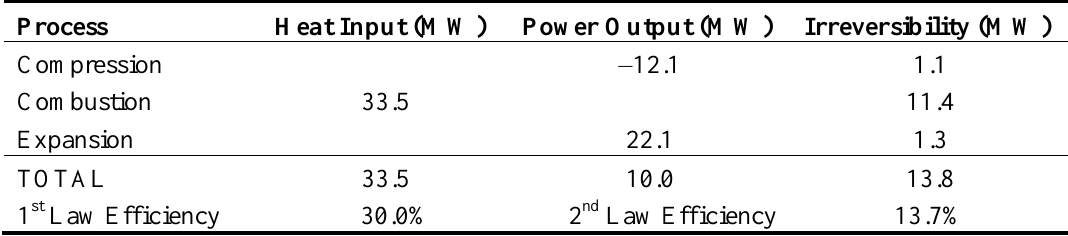
Table 1. Exergy breakdown of the standard 10 MW